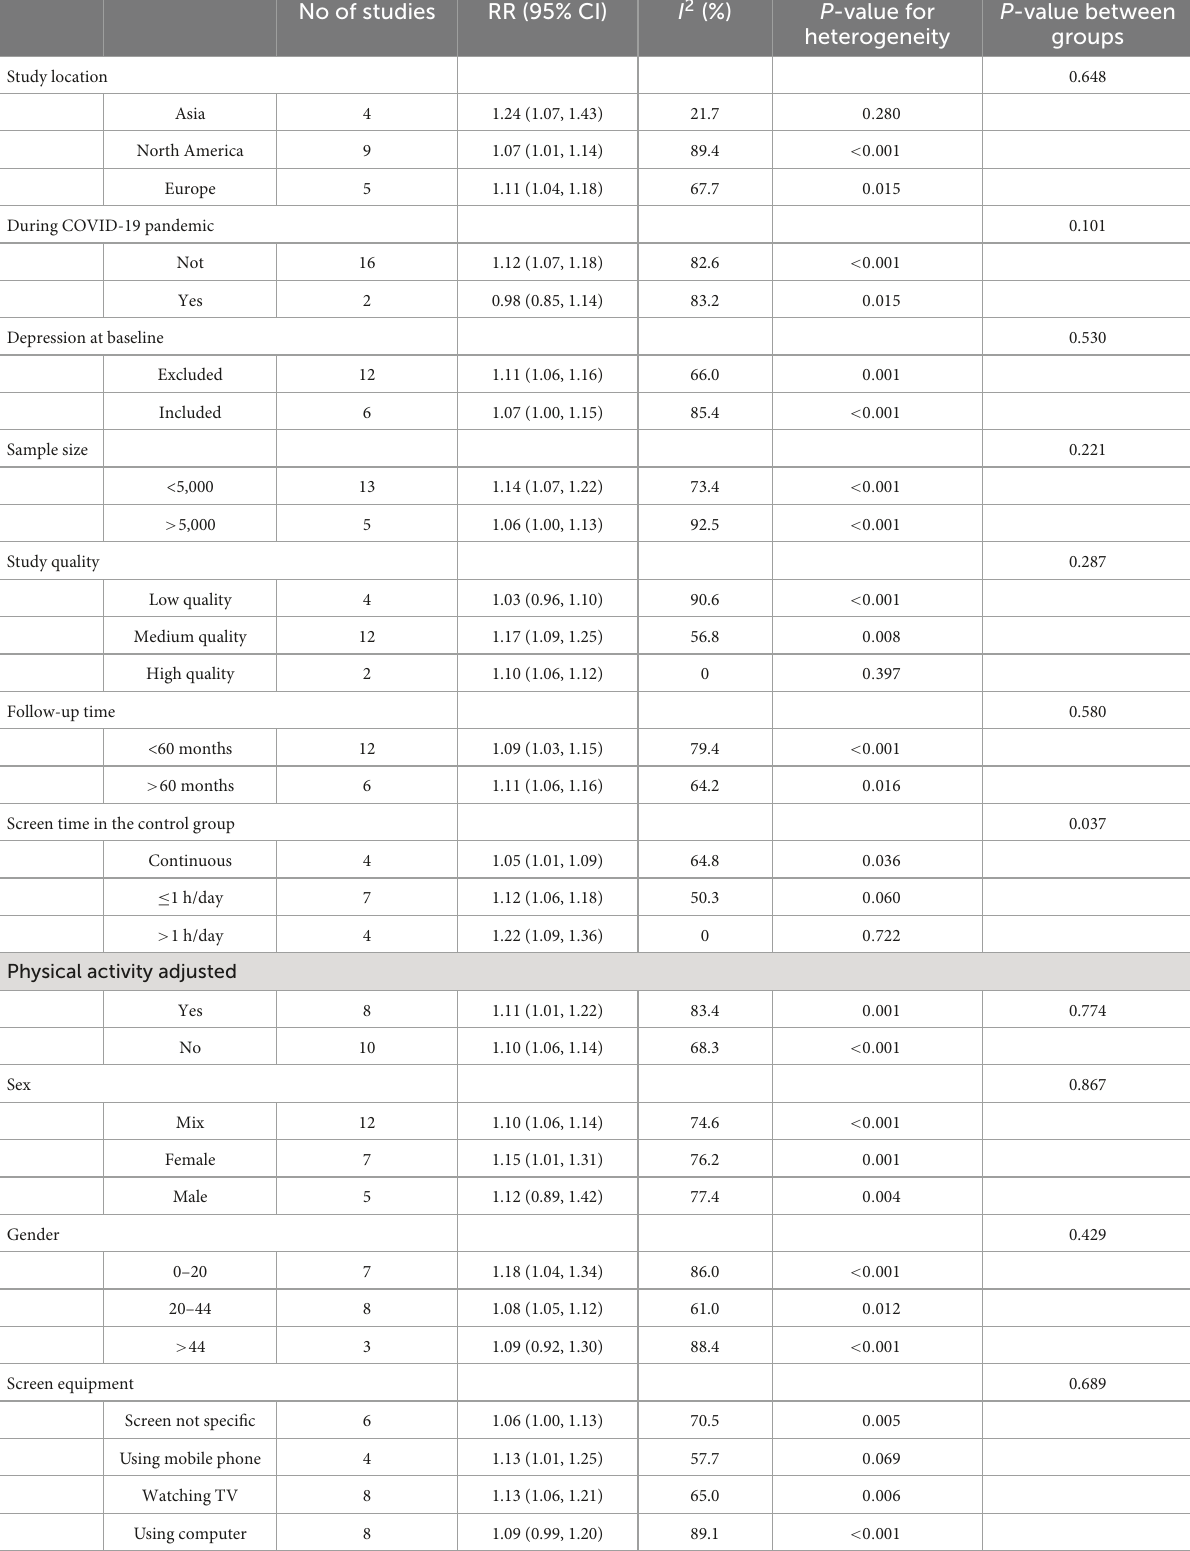
TABLE 3 Subgroup analysis of odd ratios for the association between screen time and